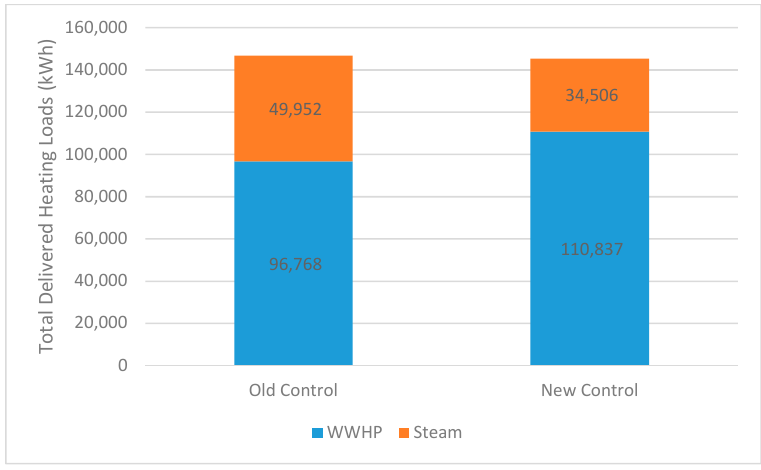
Figure 7. Daily heating outputs before the control change and regression curve-fit correlations. Energies 2018 , 11 , 211 Table 2. Source energy and energy cost savings resulting from the new control.